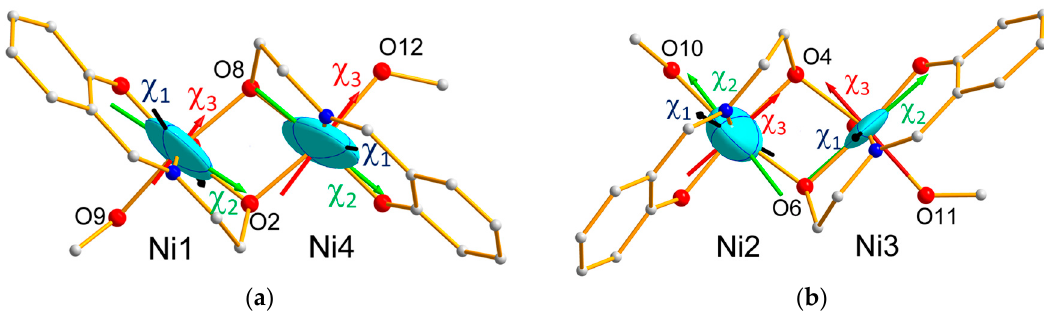
Figure 9. Magnetic ellipsoids associated to the single-ion tensors for the Ni atoms involved in AF pairs, in projection along the S 4 pseudo axis: ( a ) Ni1–Ni4; ( b ) Ni2–Ni3. The easy magnetic axes are represented in black, the mean axes in green, and the hard axes in red.